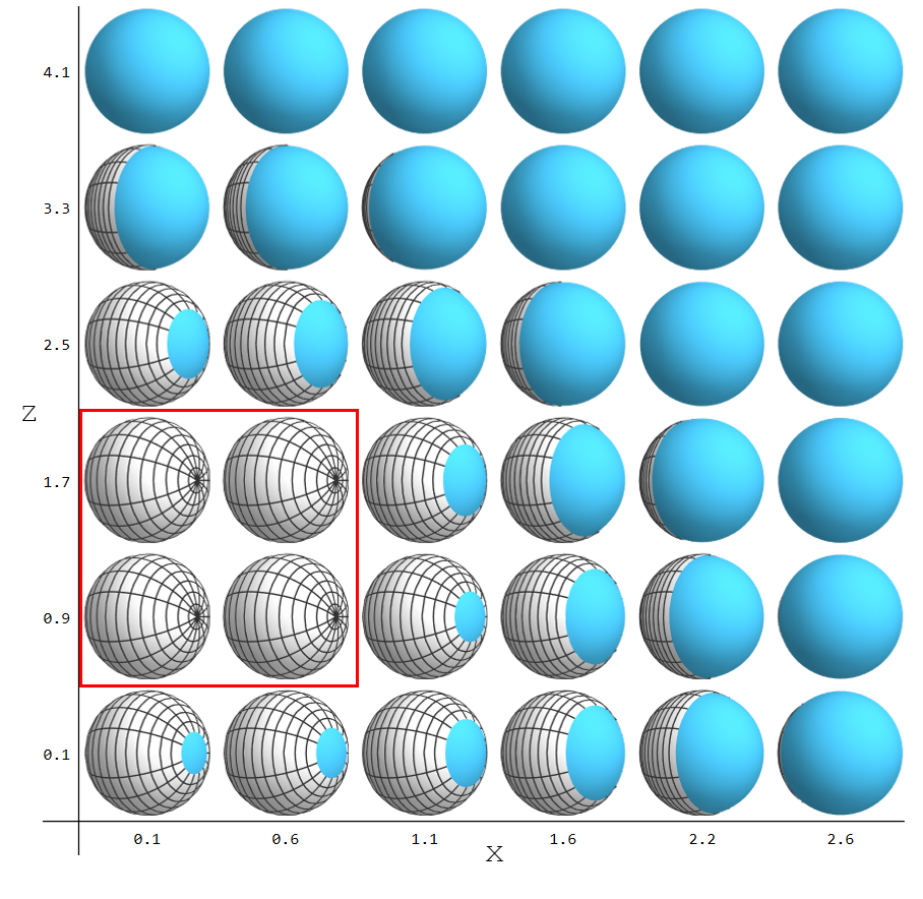
Figure 11. Array of spheres representing the spatial part of the geometry (4.7) by factoring it into a ( θ, φ ) sphere at each position ( x, z ) . The bottom line is the conformal boundary with the entangling region. The surface in figure 10(b) is shown in gray. The red square highlights the position of the